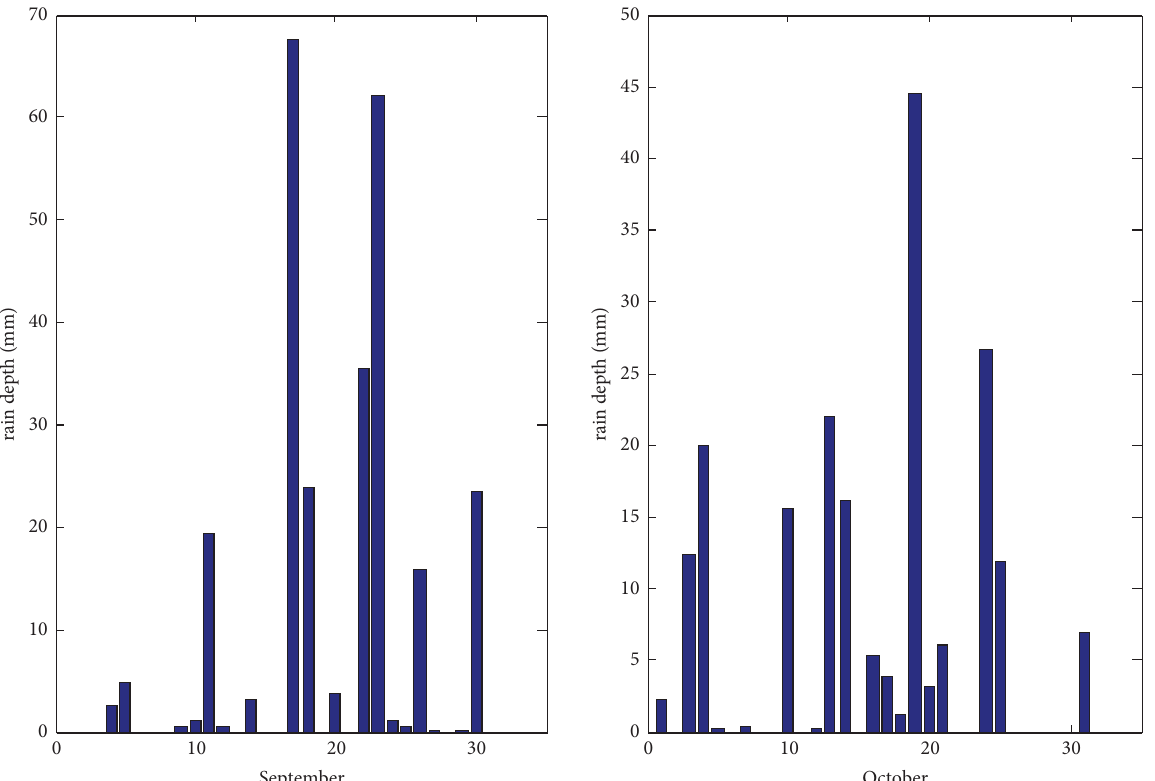
Figure 7: Rainfall amounts for September and October 2010 at